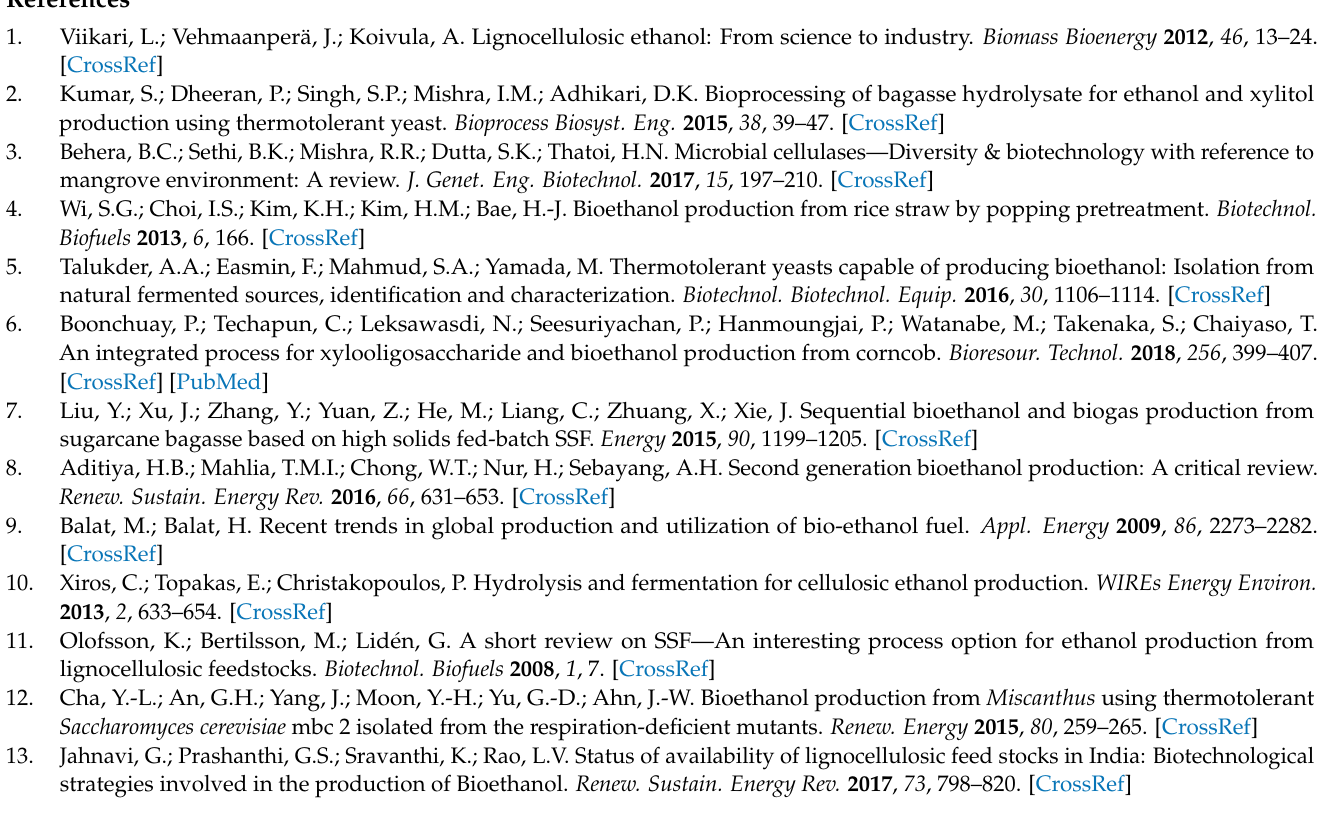
Figure S4: Time course of ethanol production from cellulose-rich corncob residue by commercial S. cerevisiae via simultaneous saccharification and fermentation (SSF) process at 35 (a), 37 (b), 40 (c), and 42 ◦ C (d). Figure S5: Time course of ethanol production from cellulose-rich corncob residue by S. cerevisiae TC-5 via simultaneous saccharification and fermentation (SSF) process at 35 (a), 37 (b), 40 (c), and 42 ◦ C (d). Figure S6: Time course of ethanol production from cellulose-rich corncob residue by commercial S. cerevisiae via prehydrolysis-simultaneous saccharification and fermentation (pre-SSF) process at 35 (a), 37 (b), 40 (c), and 42 ◦ C (d). Figure S7: Time course of ethanol production from cellulose-rich corncob residue by S. cerevisiae TC-5 via prehydrolysis-simultaneous saccharification and fermentation (pre-SSF) process at 35 (a), 37 (b), 40 (c), and 42 ◦ C